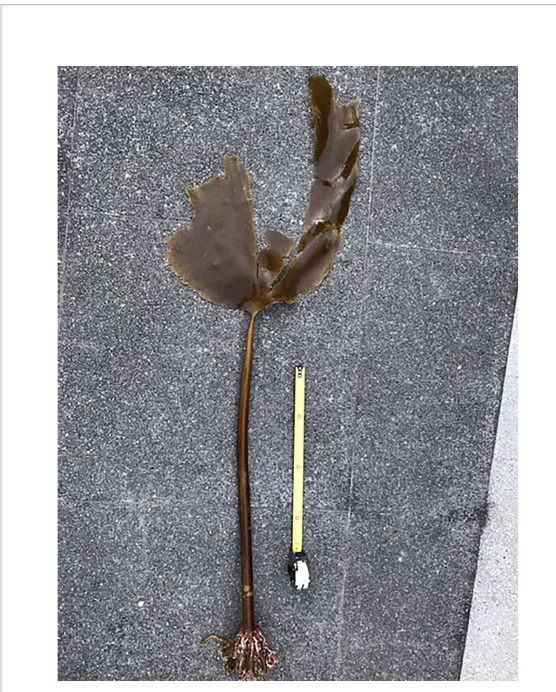
FIGURE 6 Morphology of an adult plant of Laminaria ochroleuca (MADM 7125) photographed immediately after collection with the Lula1000 submersible. Scale: 40 cm.